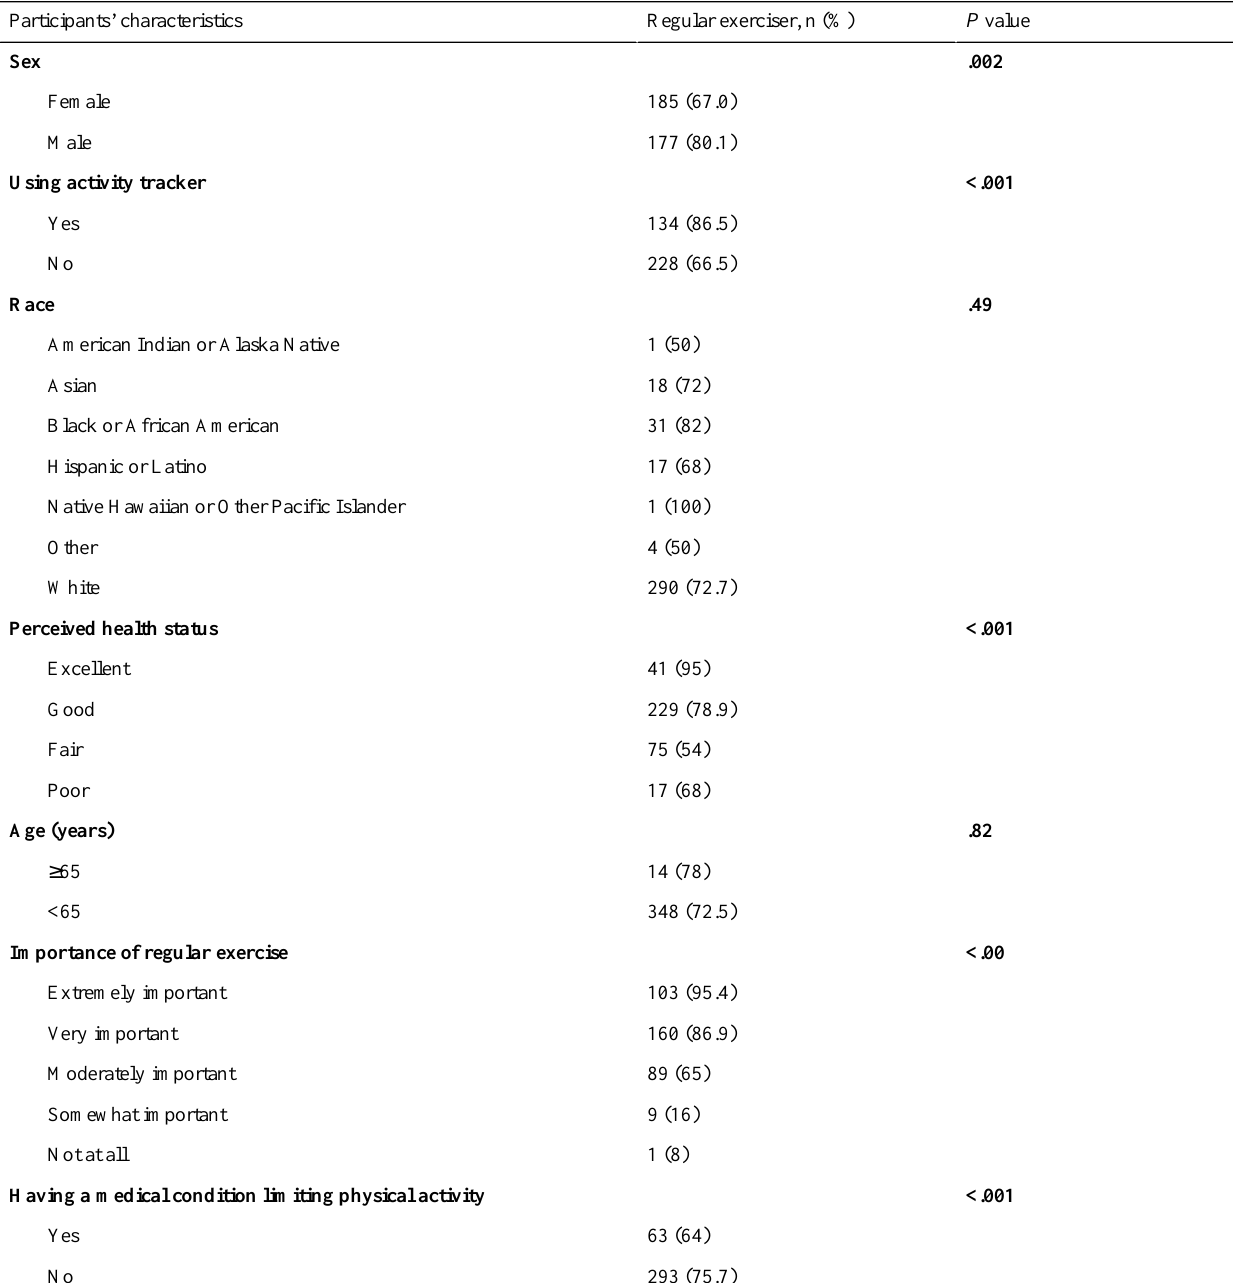
Table 3. Regular exercise ratios by